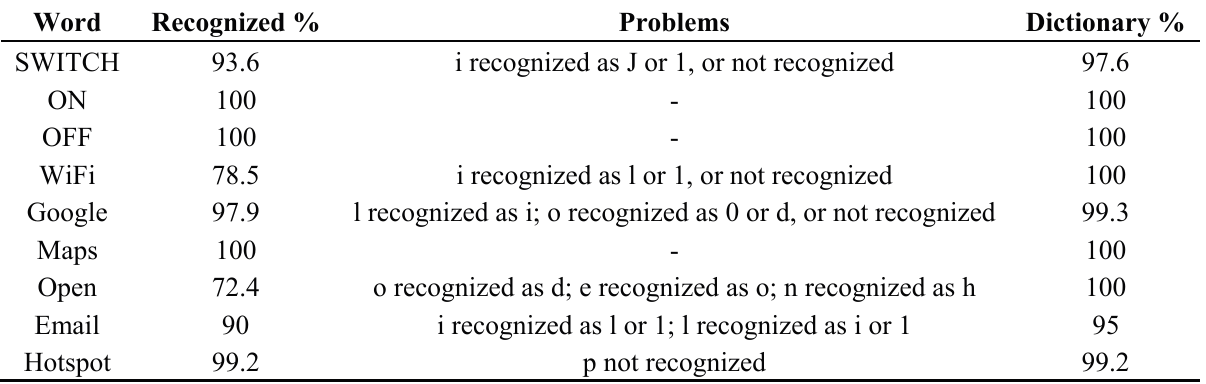
Table 3. Recognition performance of the screen words (number of testing times: